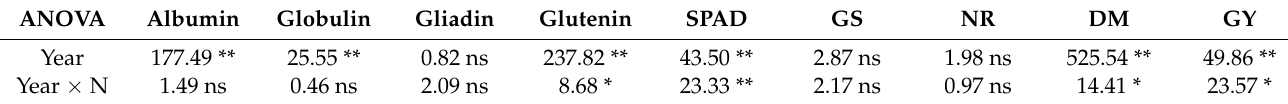
Table 1. Analysis of variance on low gluten rice yield and protein content.